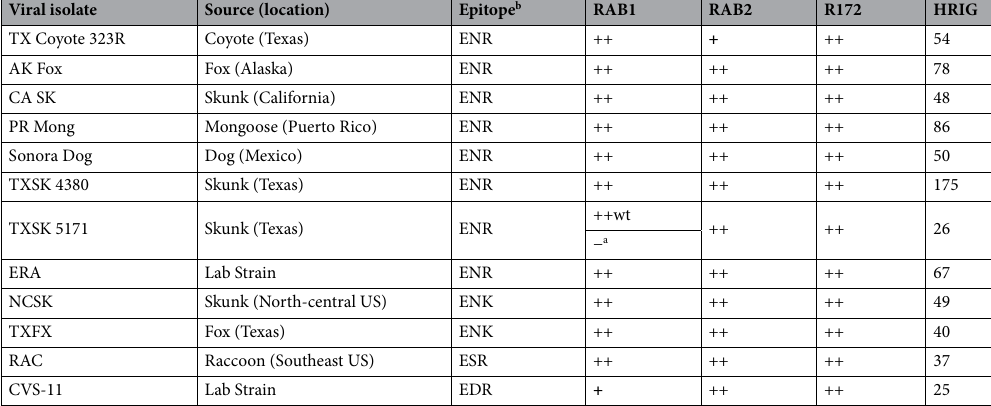
Table 2. RFFIT of RAB1, RAB2 and R172 against North America terrestrial isolates. ++EC 50 < 1 µg/mL. + EC 50 ≥ 1 µg /mL. − Not neutralized by HuMAb at the highest concentration tested. HRIG potency IU/mL against given isolate. a Lab-acquired mutation I338T identified in TKSK 5171 following additional cell culture passage. A primary wild type (wt) isolate tested. b Epitope variants with the noted residues at positions 33, 336,